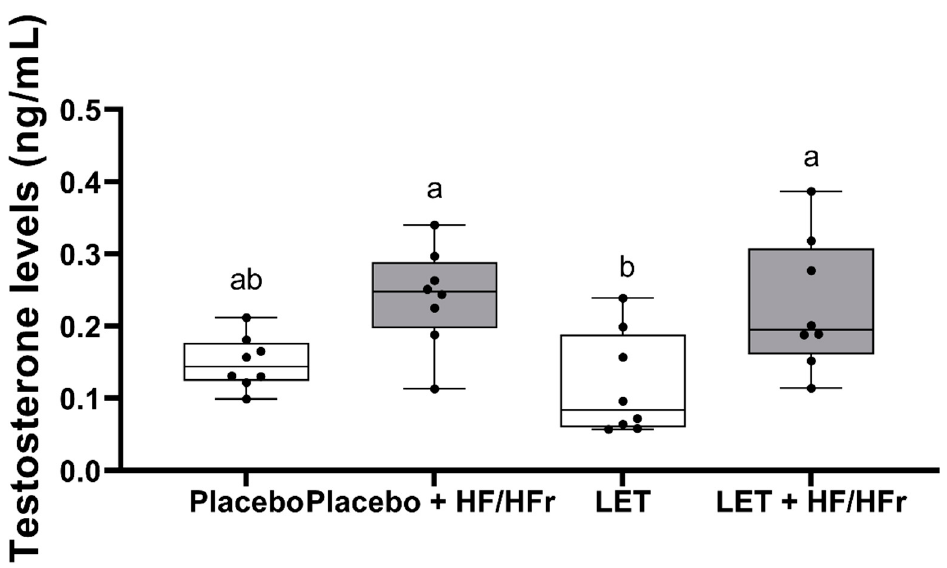
Figure 3. Effects of HF/HFr diet on testosterone levels in placebo or letrozole-treated mice. The data are presented as medians, with boxes and whiskers representing the interquartile range and the 5th − 95th percentiles ( n = 8 per group), analyzed using one-way ANOVA followed by Tukey’s post hoc test. Values with different letters show statistically significant differences ( p < 0.05).